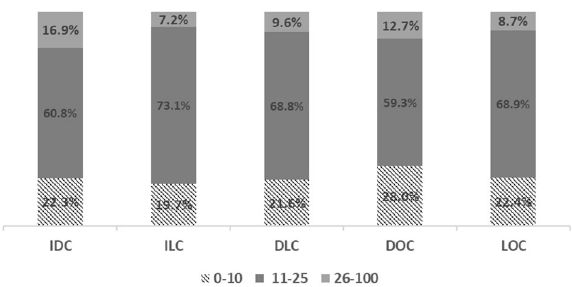
Fig. 2 Distribution of RS among breast cancer histologic subtypes. Distribution of low (0 – 10), intermediate (11 – 25), and high (26 – 100) RS in IDC, ILC, DLC, DOC, and LOC ( p <